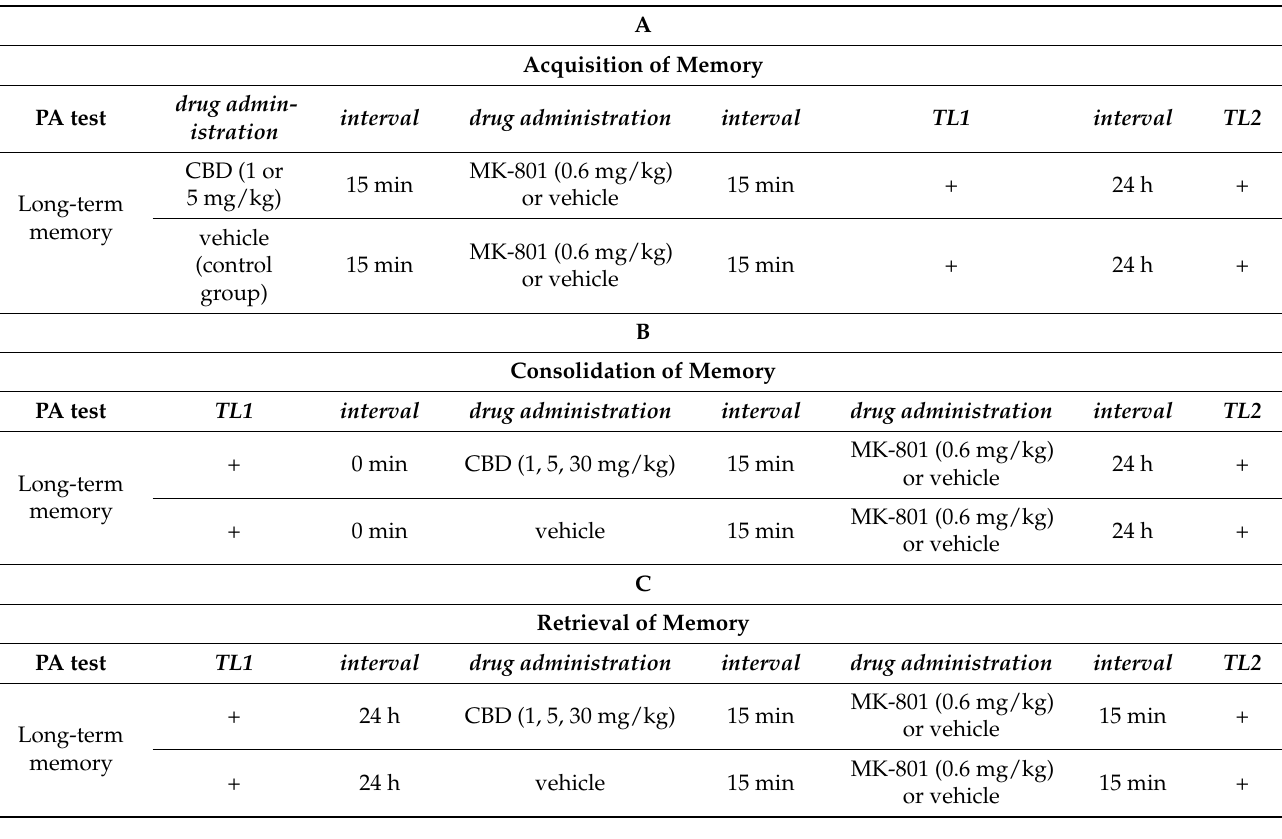
Table 2. The scheme of CBD and MK-801 co-administration during the assessment of long-term memory acquisition (A), consolidation (B), or retrieval (C) in the PA test in mice; + test